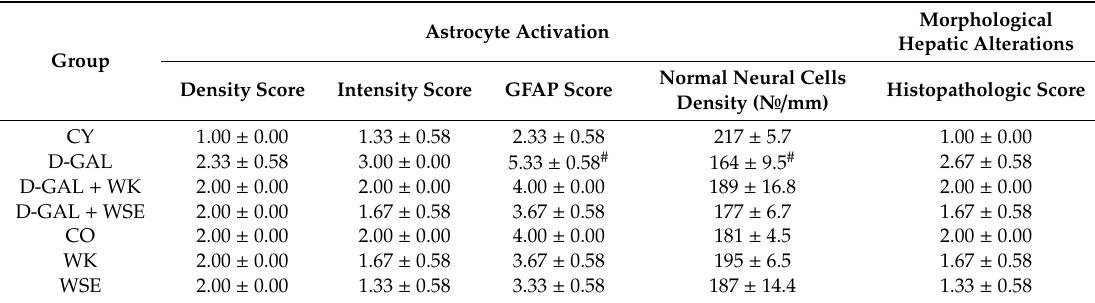
Table 4. Histological scores for astrocytes and